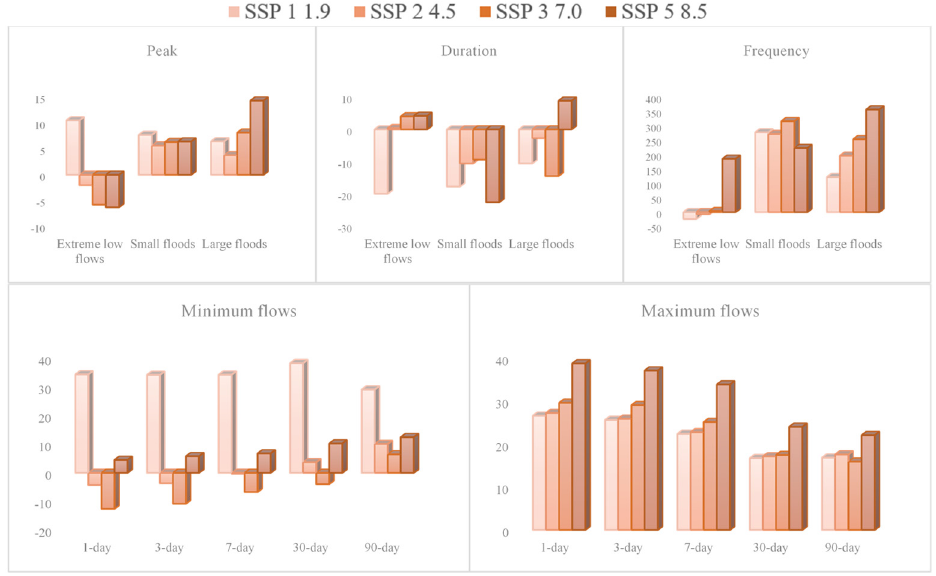
Figure 8. Impacts on the river flow parameters.